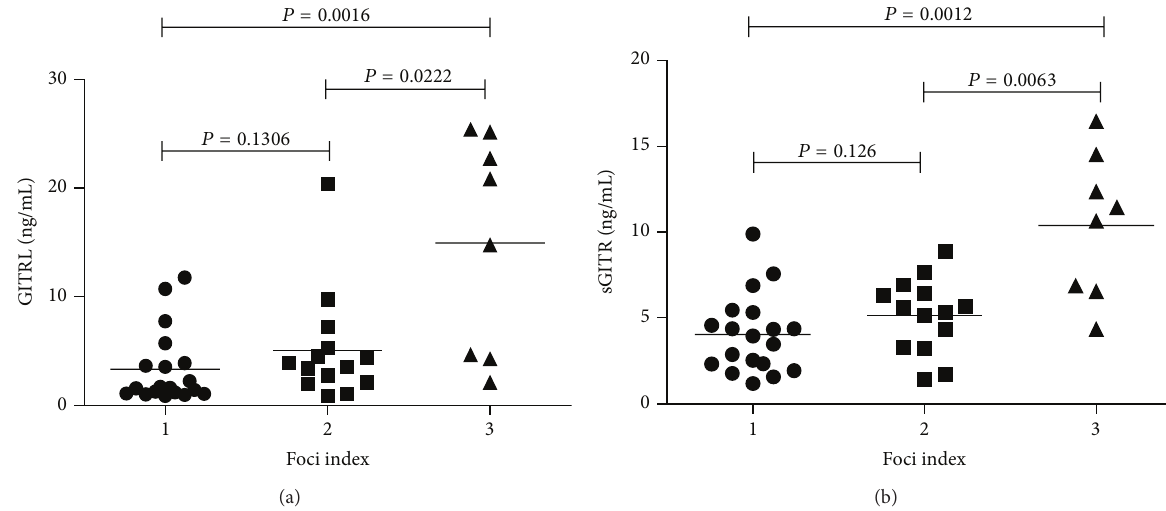
Figure 3: Comparison of serum GITRL and sGITR levels among pSS patients with different foci index. pSS patients were divided according to the foci index (1 ∼ 3) in labial salivary glands (LSGs) of lymphocytic infiltration (see Methods). (a) Serum GITRL levels were significantly higher in pSS patients with serious sialadenitis. (b) Serum sGITR levels were also elevated as foci index increased in pSS